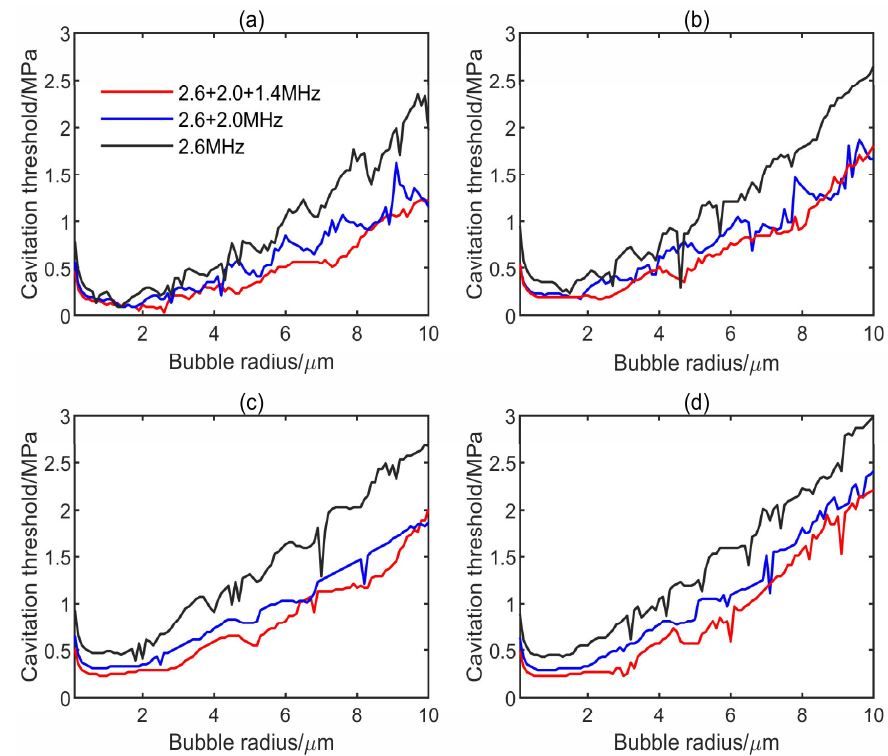
Figure 2. Transient cavitation threshold of single-frequency (2.6 MHz), dual-frequency (2.6 + 2.0 MHz), and triple-frequency (2.6 + 2.0 + 1.4 MHz) in different media: ( a ) water; ( b ) blood; ( c ) brain; ( d ) liver.